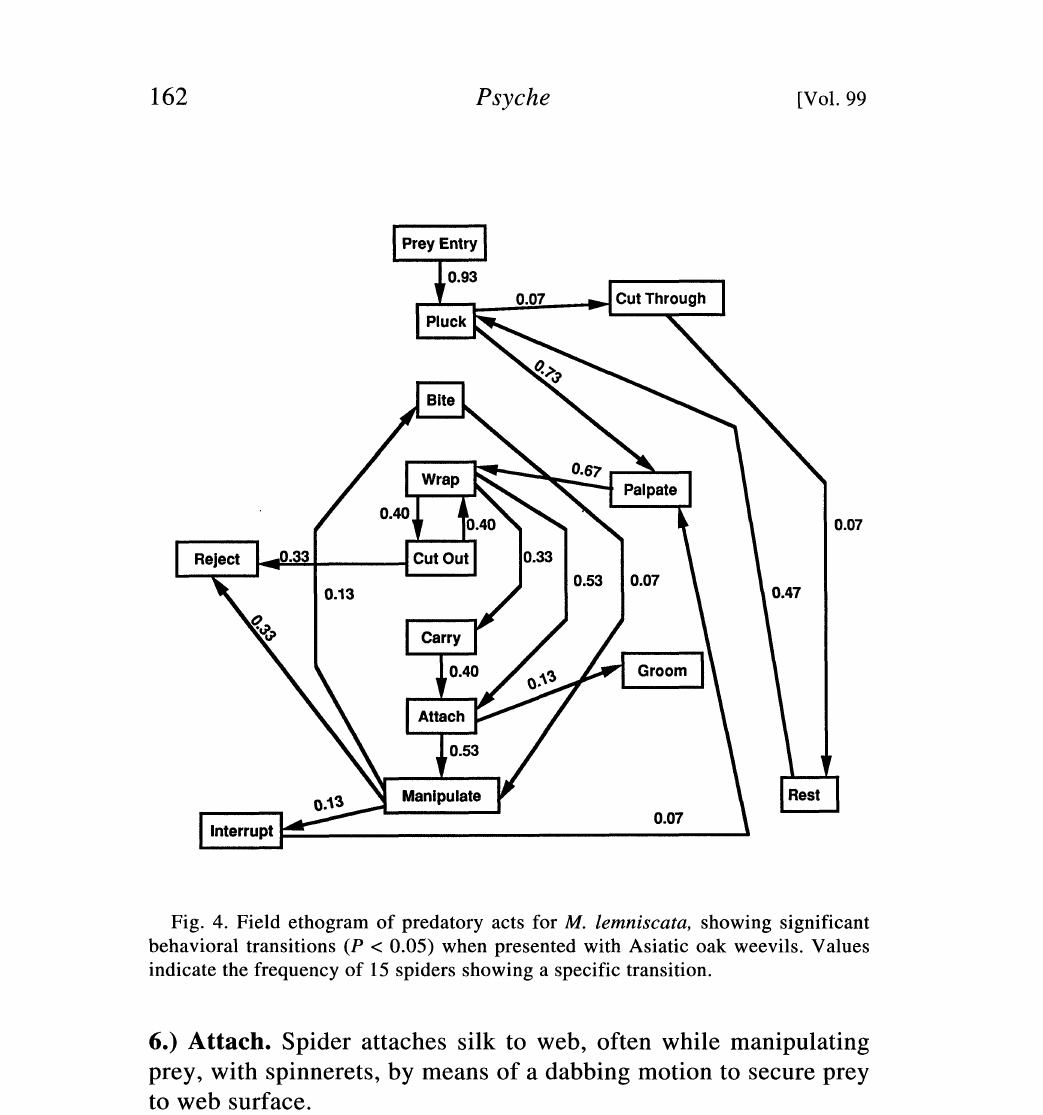
Fig. 4. Field ethogram of predatory acts for M. lemniscata, showing significant behavioral transitions (P < 0.05) when presented with Asiatic oak weevils. Values indicate the frequency of 15 spiders showing a specific